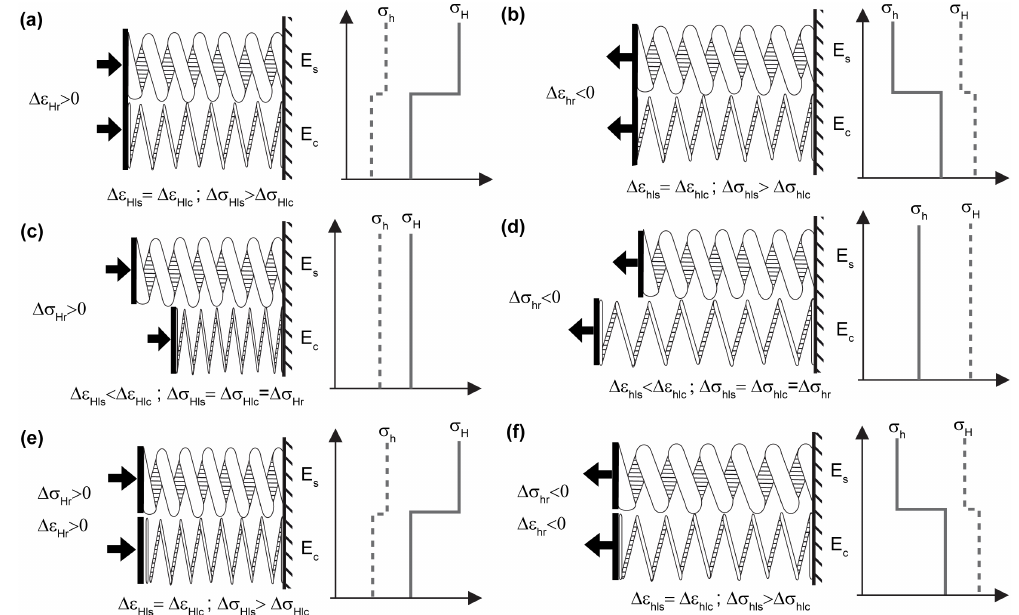
Figure 1. Conceptual representation of the stress- and strain-driven models. (a) – (f) stiff layer on top with Young’s modulus, E s , and compliant layer underneath with Young’s modulus, E c , represented by thick and thin springs, respectively. Dashed wall is non-deformable (fixed). A single regional perturbation occurs in the direction of the compression (a, c, e) or extension (b, d, f) . (a) – (b) Strain-driven model with imposed regional strain perturbation that is positive (shortening), (cid:49)ε Hr , or negative (lengthening) (cid:49)ε hr . (c) – (f) Imposed regional stress perturbation that is positive (i.e., compressional), (cid:49)σ Hr , or negative (i.e., extensional), (cid:49)σ hr . (c) – (d) Non-coupled stress-driven model; (e) – (f) fully coupled stress-driven model. Each subfigure shows the boundary conditions (next to the bold horizontal arrows), a conceptual spring diagram, the resulting local stress and strain corrections (underneath the springs), and the resulting final local stresses in each layer. Subscripts “h” and “H” are the minimum and maximum principal stresses in the direction of the extension and compression, respectively. Subscripts c and s are the compliant and stiff layers. (cid:49)σ hls , (cid:49)σ Hls , (cid:49)σ hlc , and (cid:49)σ Hlc are the local stress corrections; (cid:49)ε hs , (cid:49)ε Hs , (cid:49)ε hc , and (cid:49)ε Hc are the local strain corrections resulting from the regional tectonic perturbations, (cid:49)σ hr , (cid:49)σ Hr , (cid:49)ε hr , and (cid:49)ε Hr . Absolute values of local stress and strain corrections are considered for the comparisons. Local stress equalization happens in the non-coupled stress-driven models (c, d) . Both strain-driven and coupled stress-driven models can lead to similar local stress profiles, but with very different boundary conditions (a, b, e, f)